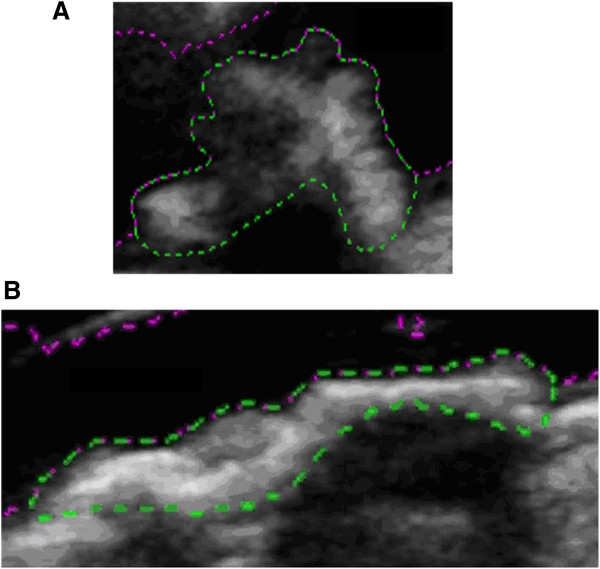
Two plaques of markedly different surface irregularity indices: (a) a symptomatic plaque with an SII of 2.25 radians/mm; and (b) an asymptomatic plaque with an SII of 1.57 radians/mm. The plaque surface is the boundary between the plaque and the arterial lumen (where the pink and green dashed lines overlap). (a) is also a plaque qualitatively classified as having an irregular surface, while (b) is a plaque qualitatively classified as having a smooth surface.